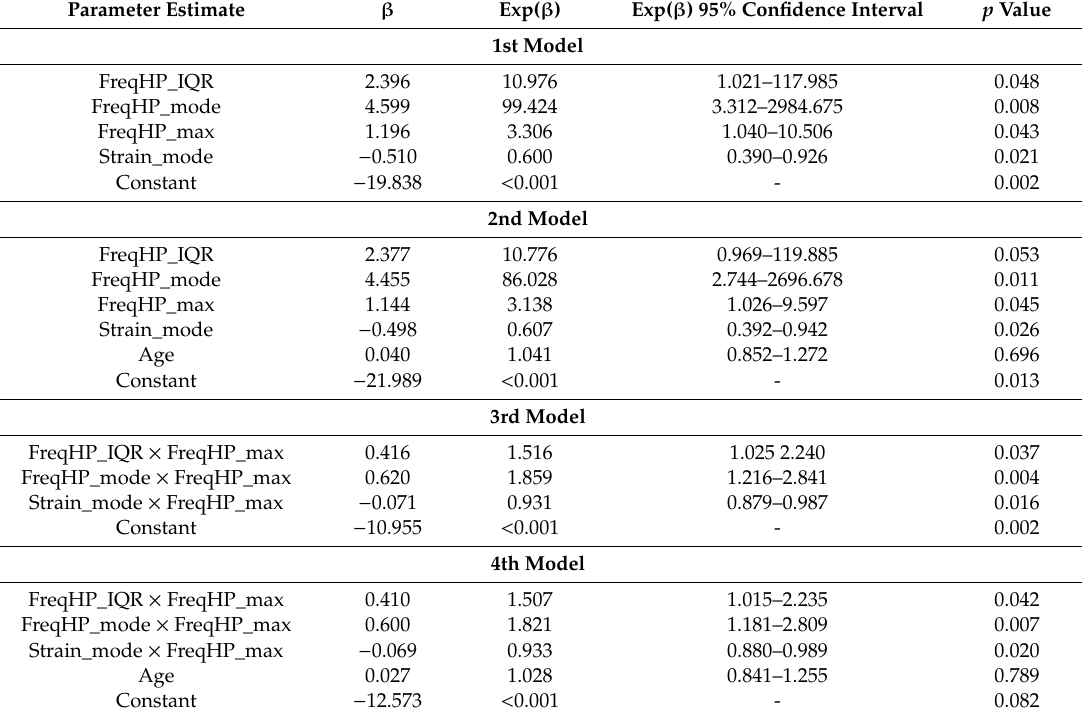
Table 2. The predictive power of medial temporal lobe tissue displacement signal parameters for the likelihood that the subject has Alzheimer’s disease. Results of logistic regression analyses.